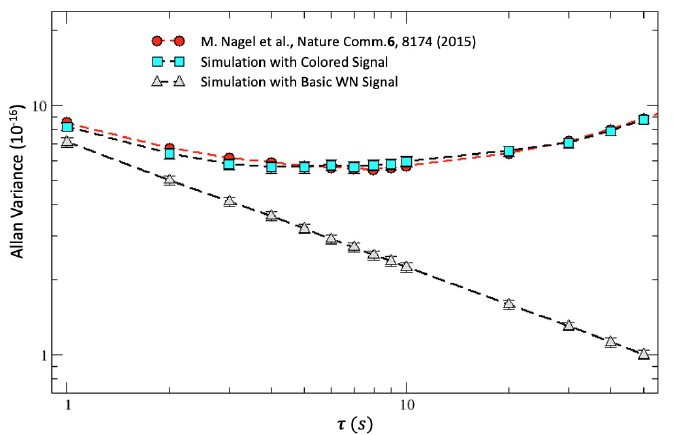
Figure 13. We report the Allan variance for the fractional frequency shift obtained from simulations of sequences of 2000 s for our basic white-noise (WN) signal and for its colored version, which was obtained with a Fourier transform of the spectral amplitude from [25]. The direct experimental results of [25] for the non-rotating setup are also